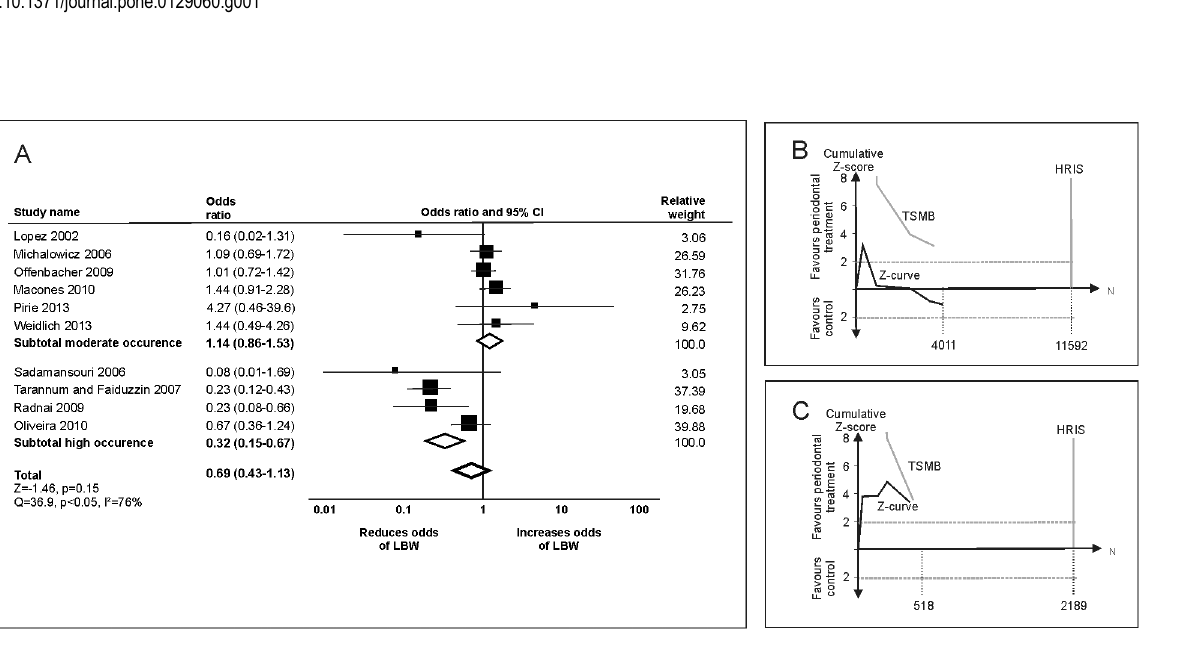
Fig 2. Periodontal treatment and low birth weight (LBW). (A) Conventional meta-analyses were conducted to analyze the effect of periodontal treatment for populations with moderate ( < 20%) and high occurrence ( (cid:1) 20%) of LBW as well as in the total population. (B) Trial sequential analysis of trials in population with moderate occurrence of LBW. The Z-curve only initially crosses the conventional boundary, with trial sequential monitoring boundary (TSMB) for benefit and HRIS not being in reach. (C) Trial sequential analysis of trials in population with high occurrence of LBW. The Z-curve does not reach the HRIS, and does not cross the